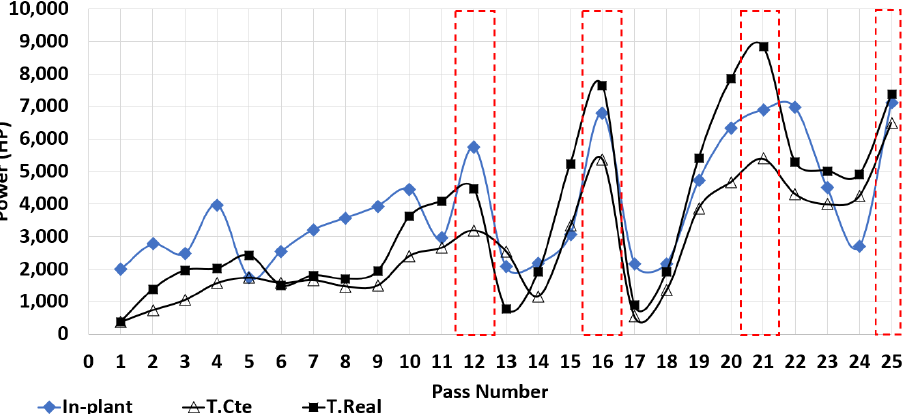
Figure 11. Maximum power for each pass of the rolling sequence for the simulations and in- plant